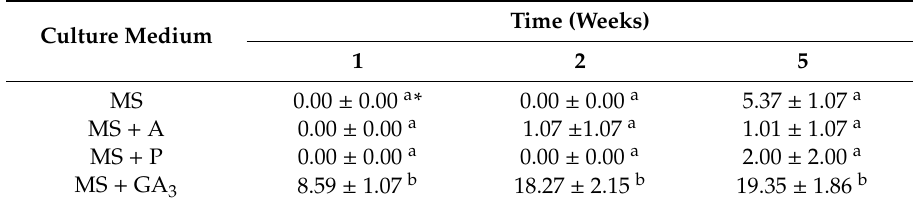
* Values represent average percentage of sprouted bulbs (%) ± SE. Different letters within columns indicate significant differences between treatments at p < 0.05 (LSD test). Table 4. Effect of GA 3 and GA inhibitors (10 μ M): ancymidol (A) and paclobutrazol (P) on bulb Table 4. E ff ect of GA 3 and GA inhibitors (10 µ M): ancymidol (A) and paclobutrazol (P) on bulb sprouting (%) cultured for 1, 2 and 5 weeks at 7 °C. sprouting (%) cultured for 1, 2 and 5 weeks at 7 ◦ C.